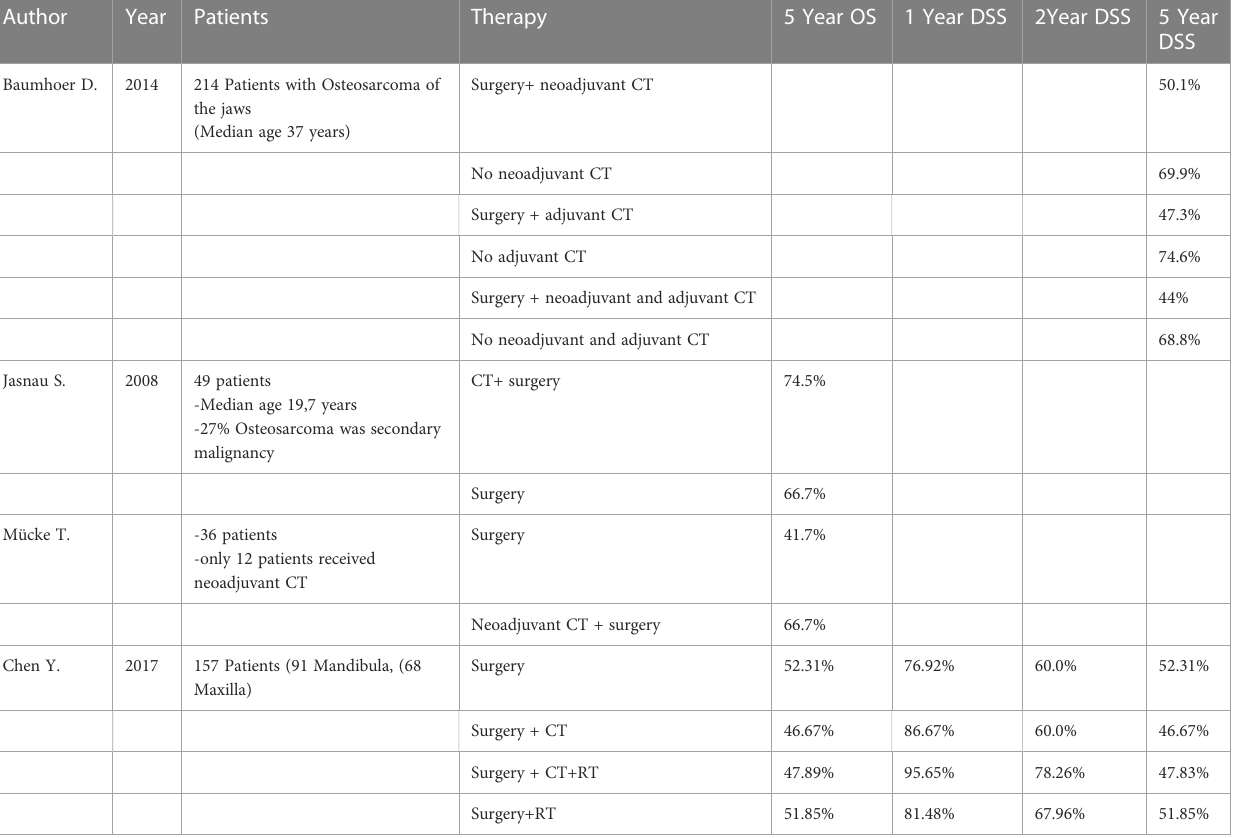
The table shows theimpact ofdifferent therapeutic interventionson survival rates ofpatients with craniofacial osteosarcoma. Theconsidered patient collective isdescribed in moredetail related to the number of patients and the respective characteristics of the collective. DSS, disease speci fi c listed in Table 1. Guo Z. et al. analyzed 19 patients with osteosarcoma of the skull base. The 5-year survival rate of these patients was only 30.5%. Guo et al. explained the low survival rate by a high recurrence rate (1-year recurrence rate 47.0%, 2-year recurrence rate 68.8%) and proximity to complex and anatomically important structures (18).